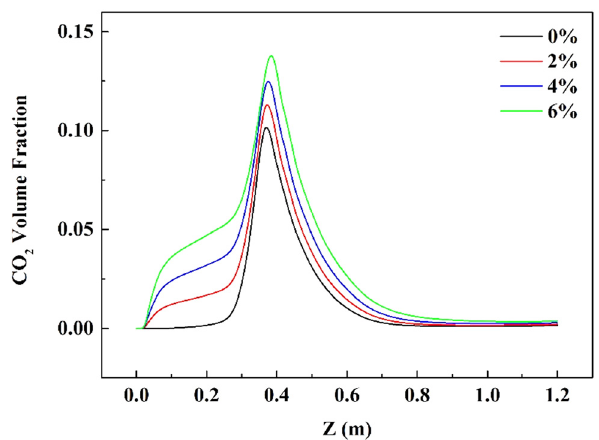
Figure 9: The change curve of CO 2 volume fraction on the axis of the furnace under di ff erent f in the hot CO 2